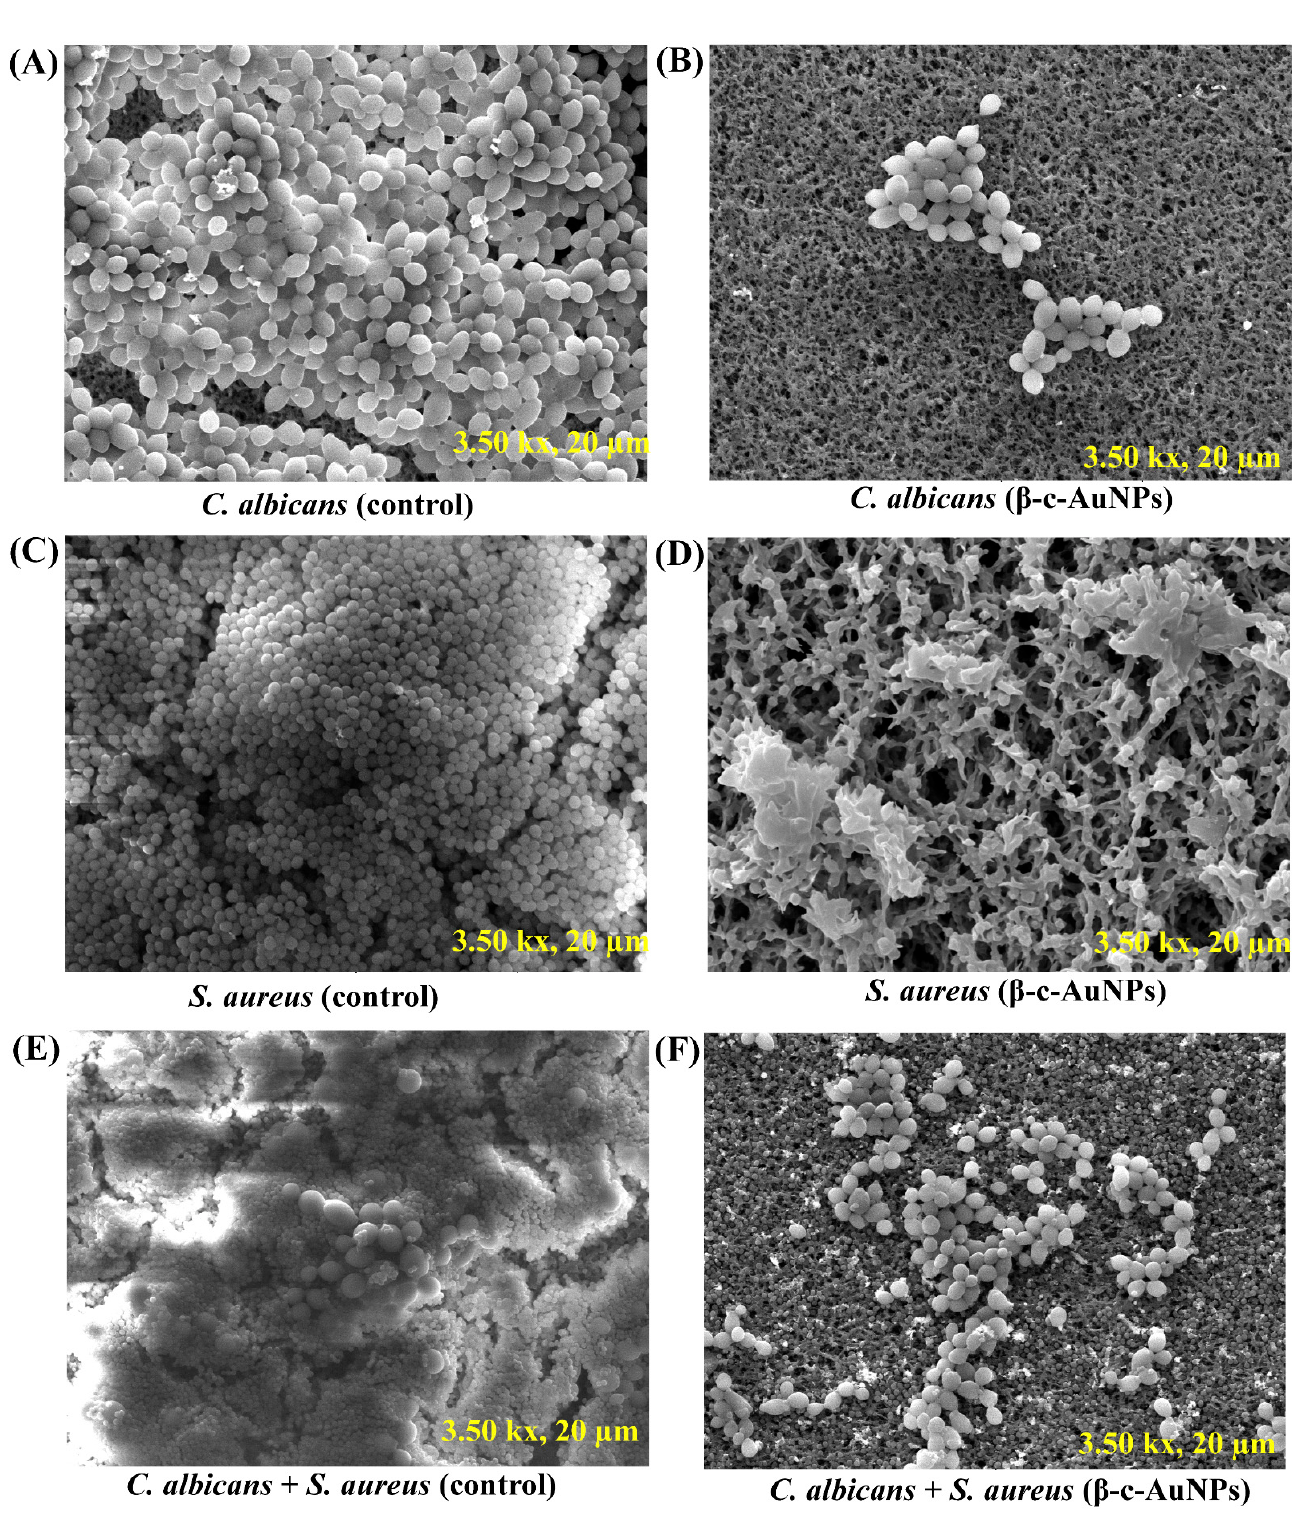
Figure 7. Effect of the subinhibitory concentration of β -c-AuNPs on the initial stage of biofilm formation. ( A ) Biofilms of C. albicans (control), ( B ) C. albicans biofilm treated with β -c-AuNPs, ( C ) S. aureus biofilms (control), ( D ) S. aureus biofilms treated with β -c-AuNPs, ( E ) S. aureus + C. albicans mixed biofilms (control), and ( F ) S. aureus + C. albicans mixed biofilms treated with β -c-AuNPs.